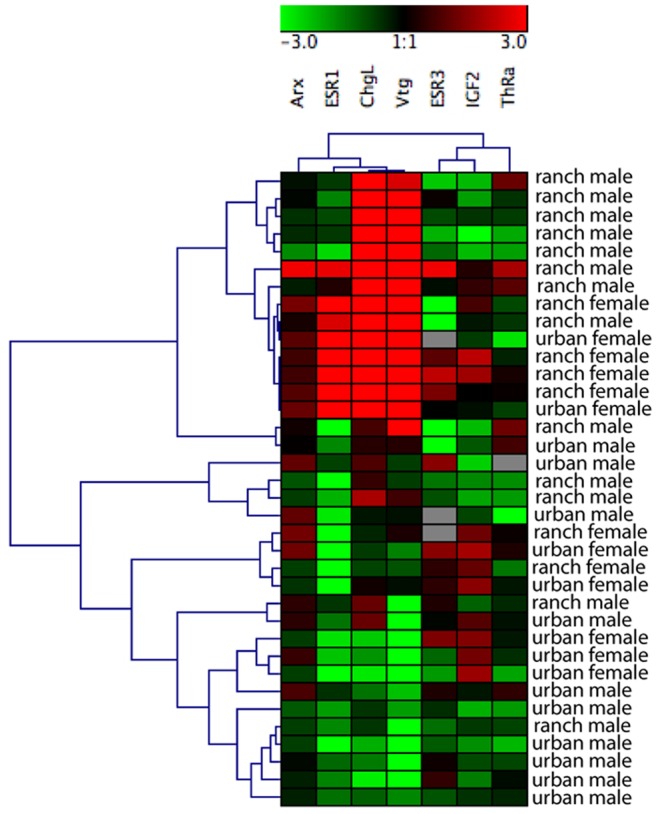
Heat map of transcript expression by site and sex.Expression of endocrine responsive genes (Arx, ESR1, ChgL, Vtg, ESR3, IGF3, and ThRa) was assessed using qPCR for male and female silversides collected at ranch and urban sites. Color indicates fold change in gene expression relative to a reference gene; red = upregulation, green = downregulation. Gray indicates missing data. Individual samples are ordered according to the results of a hierarchical cluster analysis.